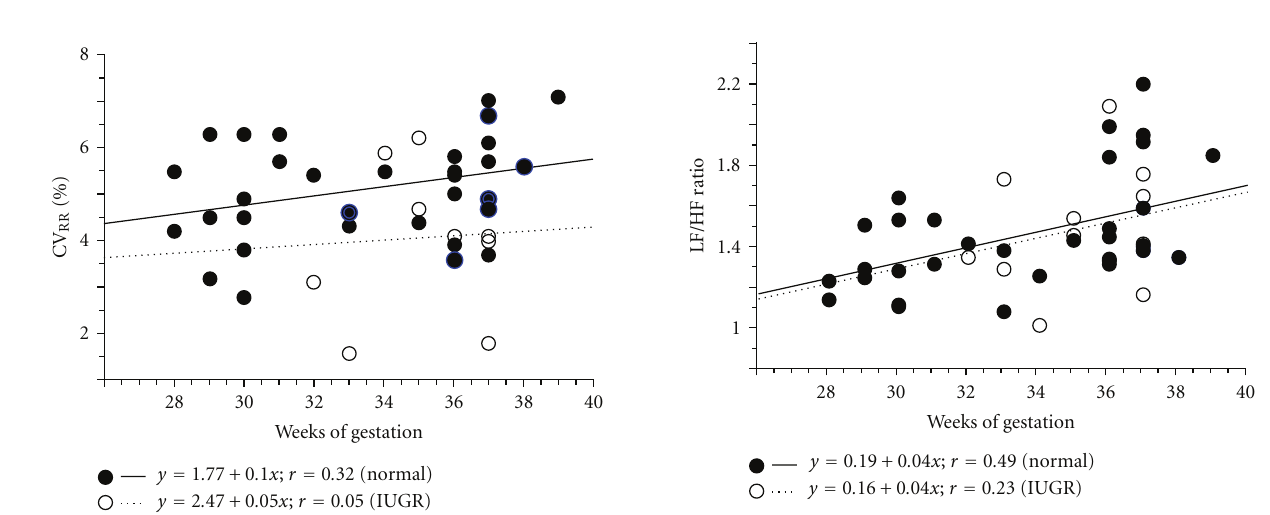
Figure 4: Correlation between the coe ffi cient of variance (CV RR ) and gestational age in normal pregnancy and in IUGR (normal pregnancy: • —; IUGR: ◦ ... ).